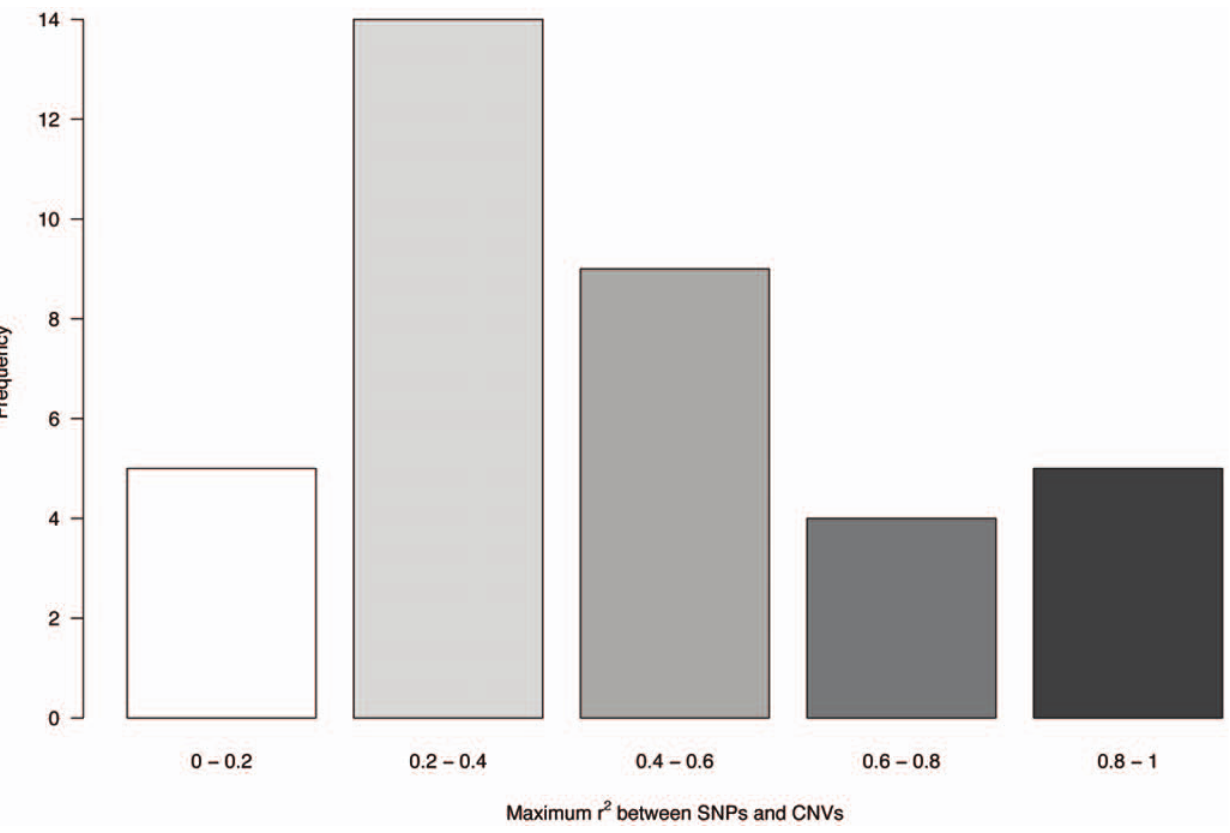
Figure 3. Linkage disequilibrium between HapMap SNPs and CNVs. The distribution of maximum measured r 2 value for the SNPs analyzed for each CNV is plotted in the histogram, which represents the frequency of findings (Y axis) in each range of LD values